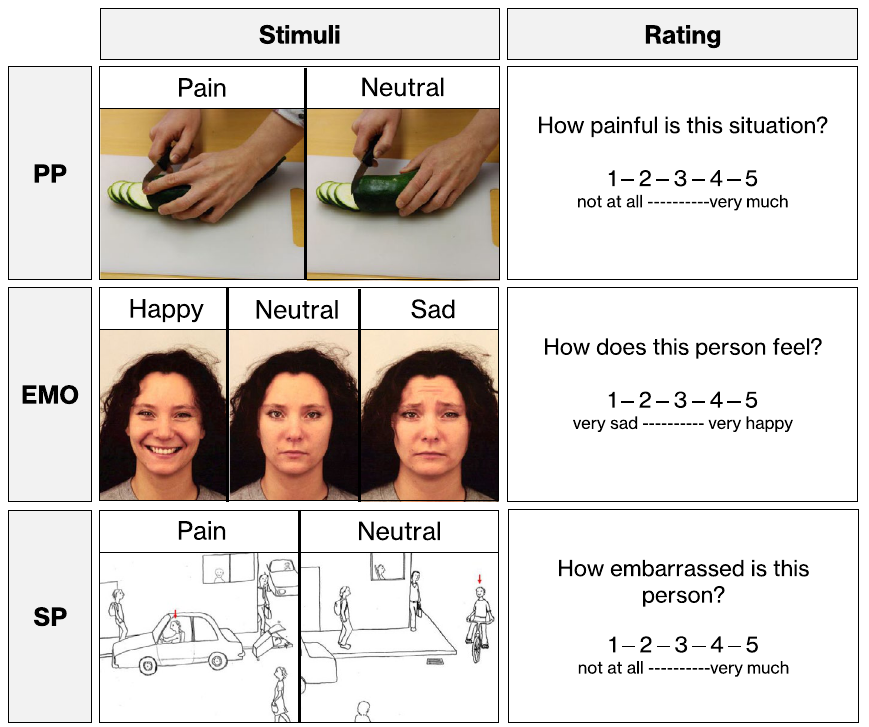
Figure 1. Stimuli and rating questions of the three experiments. In all three experiments, patients were required to view stimulus pictures and respond to a subsequent rating question. The upper row shows two example stimuli of the physical pain (PP) experiment, reflecting the two stimulus categories used in the experiment, and the respective rating question. Example stimuli and rating questions for the basic emotions (EMO) and social pain (SP) experiments are displayed in the middle and lower row. Stimuli for the basic emotions experiment were taken from the Karolinska Directed Emotional Faces database 69 , which is publicly available and may be used for non-commercial scientific research purposes (https:// www. kdef. se/; stimuli shown here: BF02HAS, BF02NES, BF02SAS). In the physical pain and basic emotions experiment, patients were instructed to look at the photograph for 4.5 s and to rate the intensity of pain or the quality of emotion that the depicted person would experience. In the social pain experiment, sketches showed a protagonist, indicated by a red arrow above their head, in potentially embarrassing (socially painful) or neutral situations. Each sketch was accompanied by a sentence introducing the current scenario [for these specific situations: “You are on the pavement: a car driver knocks over a trash can while backing into a parking space.” (Pain); “You are in the city: a cyclist turns right.” (Neutral)]. Patients were instructed to look at each sketch for 12 s and to subsequently rate the intensity of the embarrassment the protagonist would feel in the respective scenario. The length of the rating phase was 3 s in all